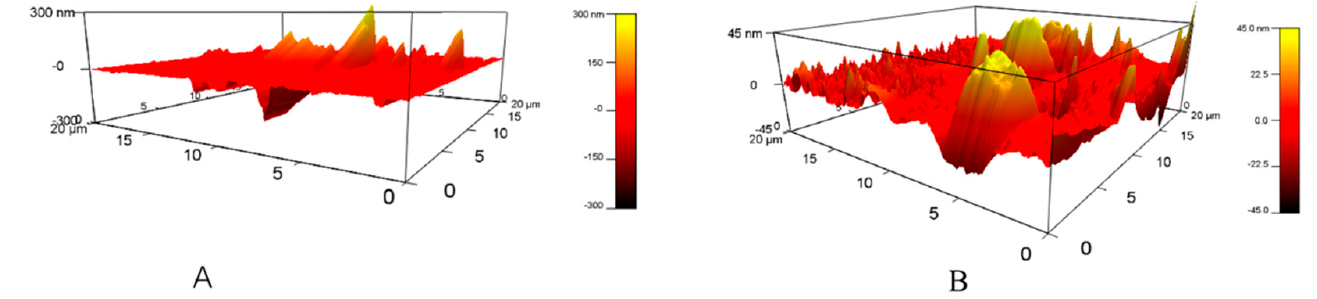
Figure 14. AFM 3D images before and after the interaction of MDA and Q[7] ( A ): MDA ( B ): MDA + Q[7] (C Q[7] = 10 − 4 mol/L, C MDA = 10 − 3 mol/L).